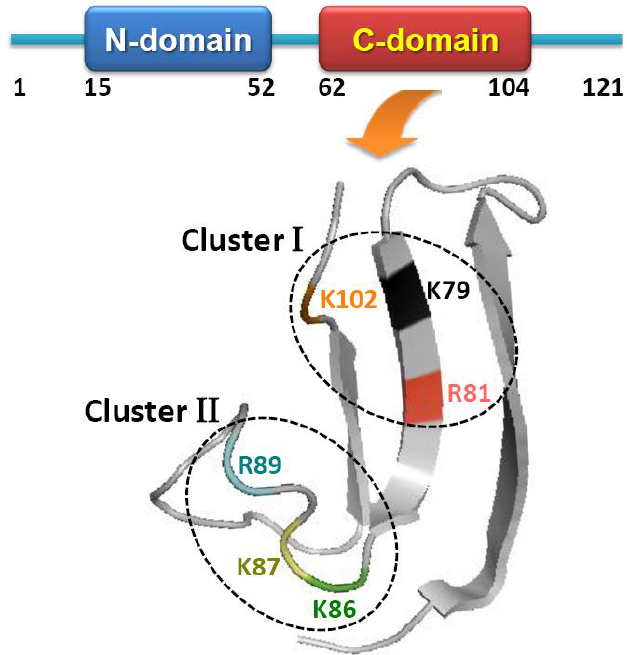
Figure 1. The domain structure of MK and the three-dimensional structure of its C-terminal